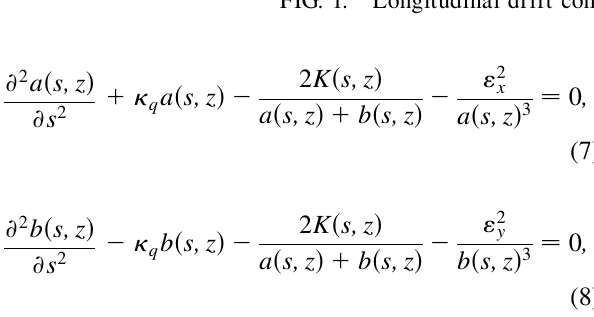
FIG. 1. Longitudinal drift compression of a heavy ion fusion